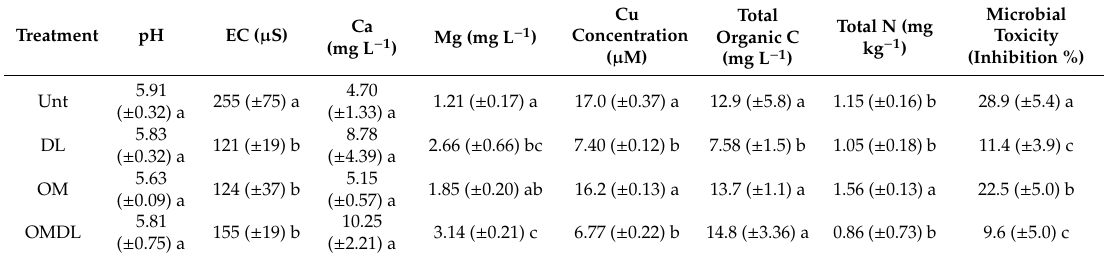
Table 1. Chemical properties and ecotoxicity of the leachates from untreated and phytomanaged soils.